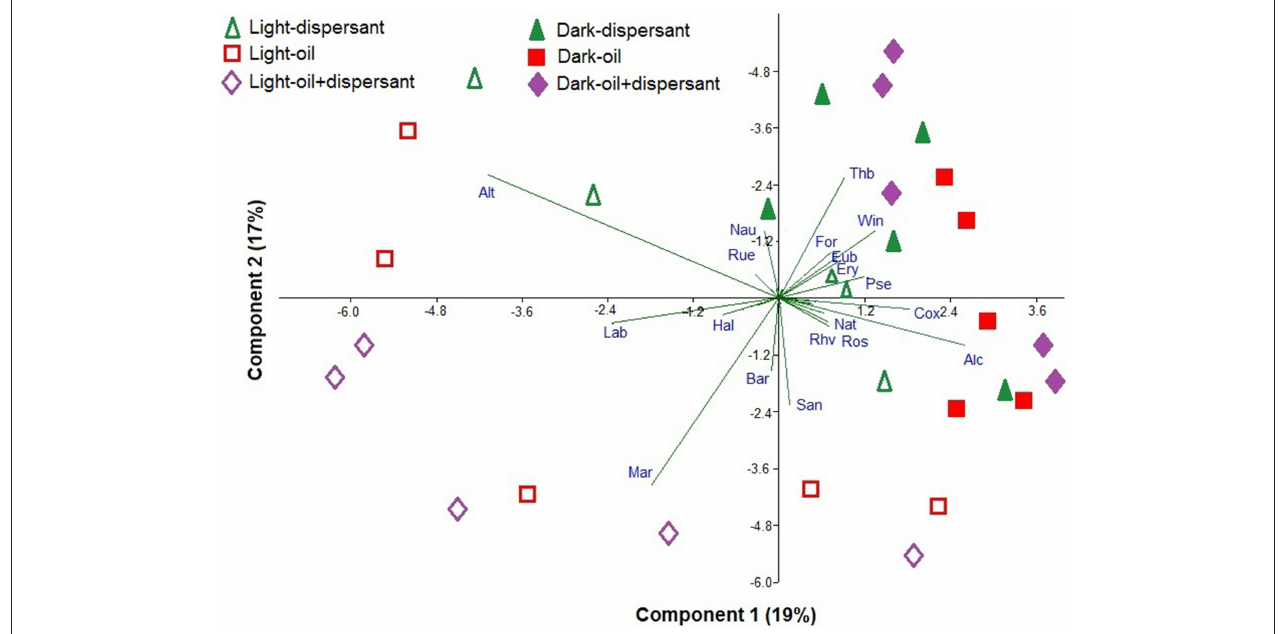
FIGURE 5 | Principal component analysis of the Hellinger-transformed relative abundances of genera in dispersant, oil, and oil+dispersant treatments. The arrows represent the genus component loadings. Alt, Alteromonas ; Lab, Labrenzia ; Hal, Halomonas ; Mar, Marinobacter ; Bar, Bartonella ; San, Sandarakinotalea ; Rhv, Rhodovulum ; Ros, Roseobacter ; Nat, Natronocella ; Alc, Alcanivorax ; Cox, Coxiella ; Pse, Pseudomonas ; Ery, Erythrobacter ; Eub, Eubacterium ; Win, Winogradskyella ; For, Formosa ; Thb, Thalassobius ; Nau, Nautella ; Rue, Ruegeria